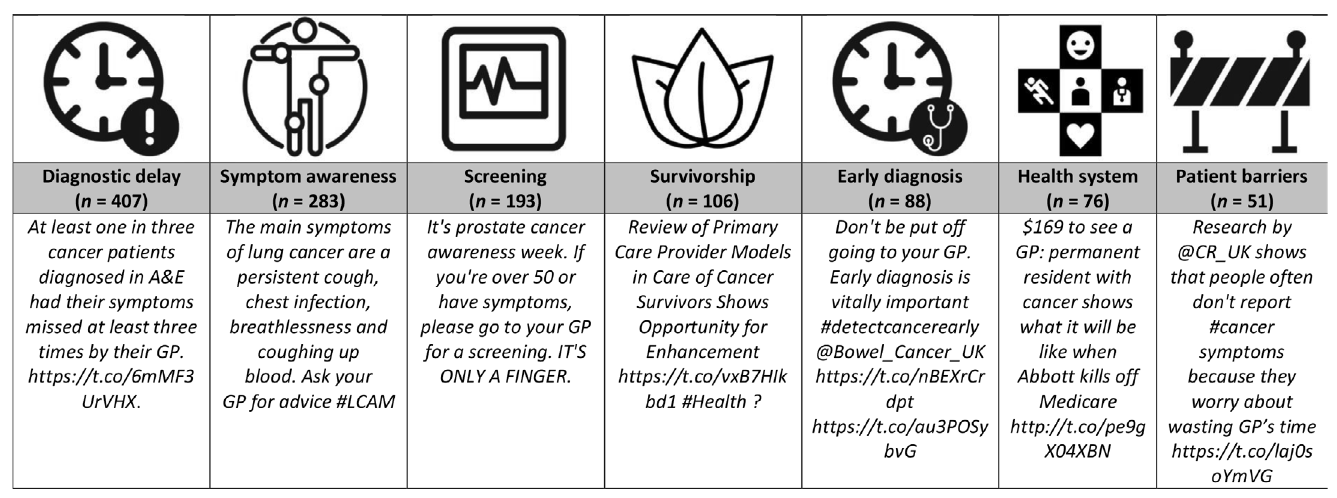
Figure 1 Key themes identified and representative tweets of each